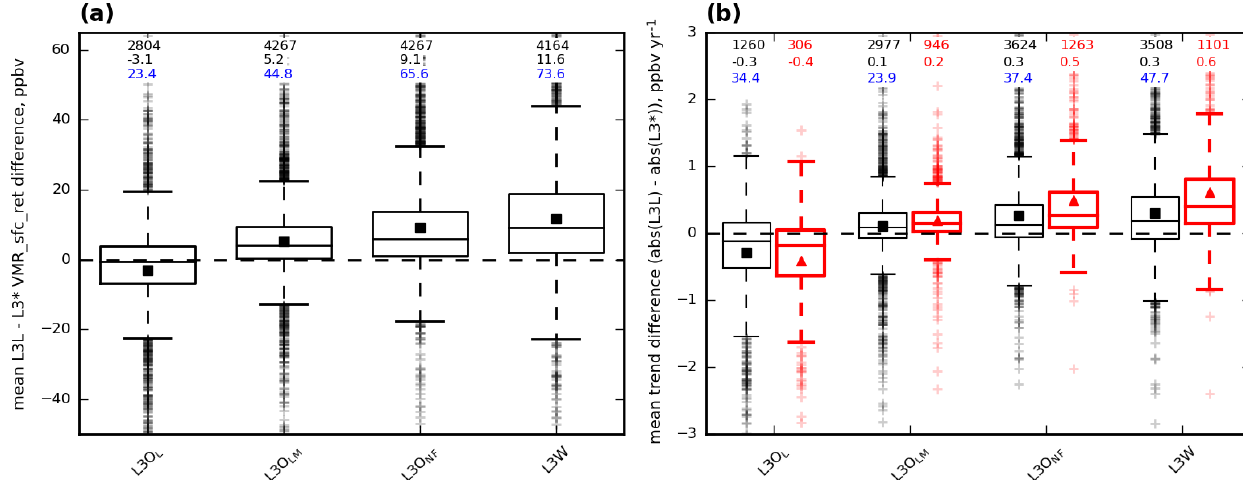
Figure 7. Boxplots showing how mean VMRs and trends compare from selected L3O subsets and L3W to L3L. Values compared are calculated from all available data across the study period. Mean values are represented by filled squares, and values above the boxplots correspond to the number of grid boxes with data for that boxplot (black, top row), the mean value (black, second row), and the percentage of grid boxes represented in that boxplot that feature a significant difference with L3L (blue, third row). The comparison is calculated as L3L − L3* in both cases; therefore a point above (below) the black y = 0 line indicates that the value being compared is greater (lower) in L3L. (a) Mean VMR differences between L3L and the indicated L3O subset or L3W. Note that the n value is different for each boxplot because not all L3 subsets are present at every coastal grid box, as shown in Sect. 3.3.1. (b) Differences in gradients (absolute values) detected using WLS regression analysis between L3L and the indicated L3O subset or L3W. Shown are the differences for all coastal grid boxes where WLS could be performed for both datasets compared (black, mean values represented by filled black squares) and for only the sample of those grid boxes where the detected trend is significant ( p < 0.1) in both (red, thicker lines, mean values represented by filled